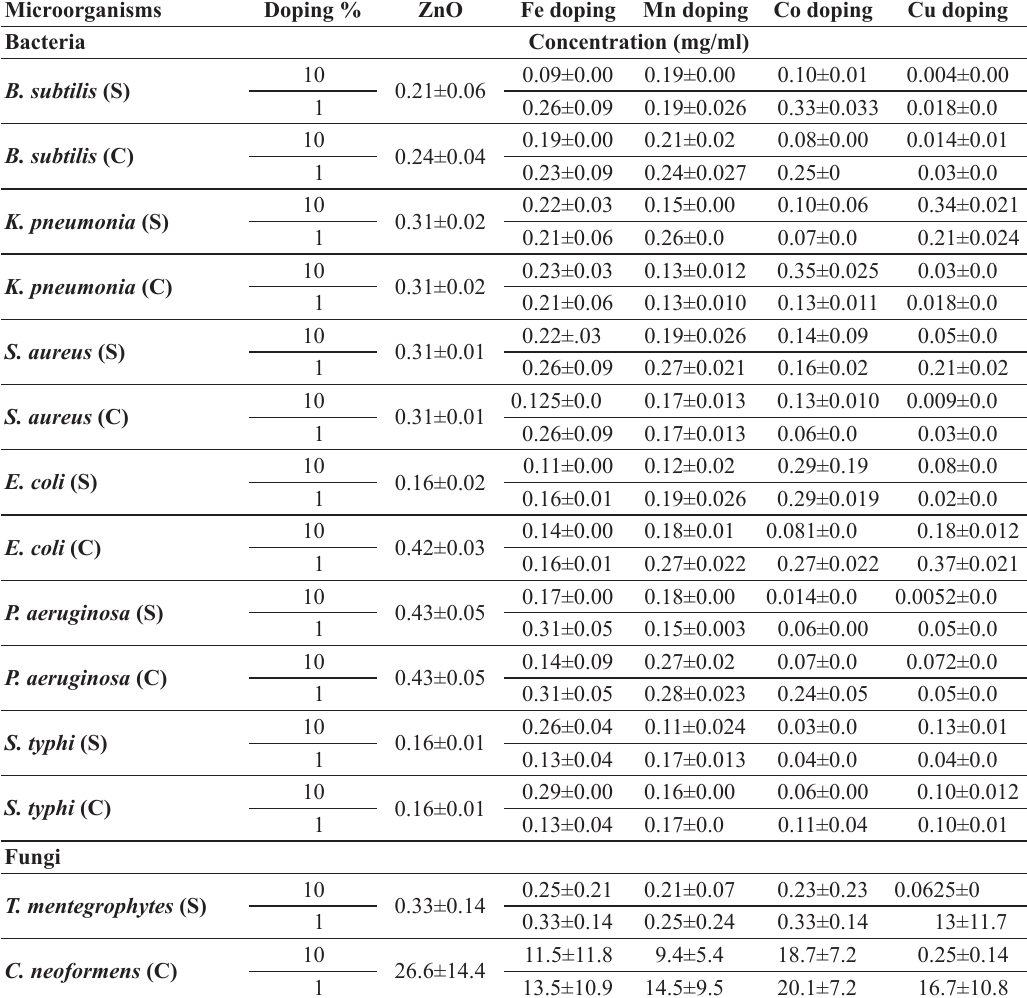
Minimum inhibitory concentration (mg/ml) of pure ZnO and doped ZnO nanoparticle against various microorganisms. S: standard isolate, C: Clinical